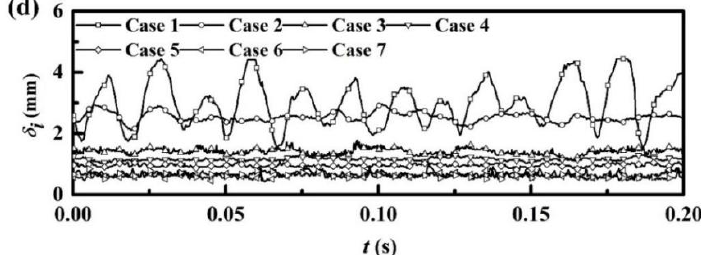
Figure 5. Temporal film thickness under different experimental conditions. ( a ) variations of the temporal film thickness at r = 0 mm, ( b ) variations of the temporal film thickness at r = 5 mm, ( c ) variations of the temporal film thickness at r = 12 mm, ( d ) variations of the temporal film thickness at r = 0 mm in Cases 1~7.